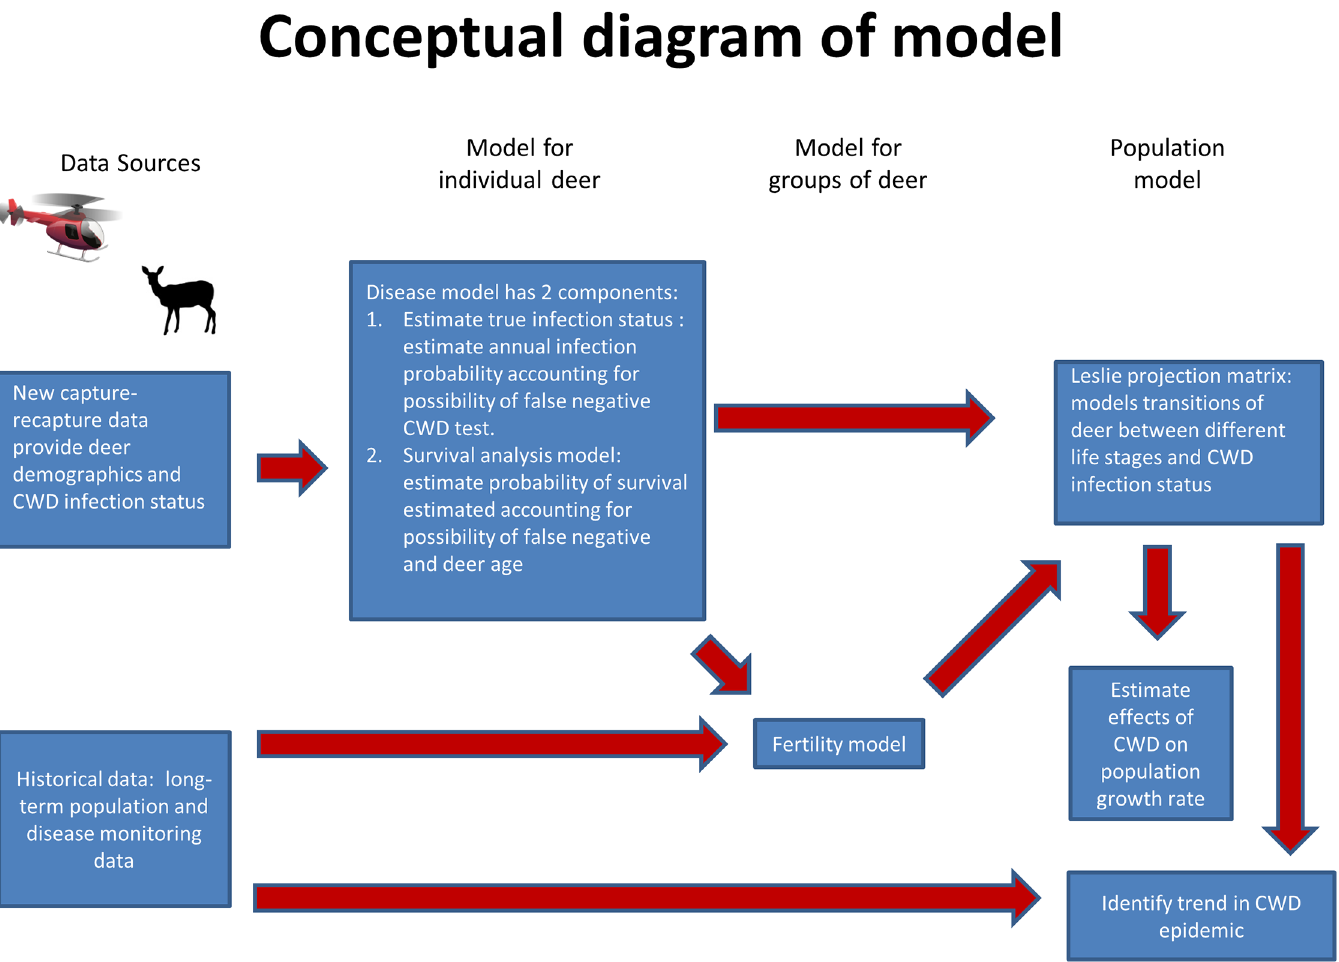
Fig 1. Hierarchical Bayesian framework used to integrate a matrix population and disease model with field data. We assimilated a model with long- term monitoring and capture-recapture data to forecast the effect of CWD on deer population growth, forecast short-term CWD prevalence, and assess how the epidemic is